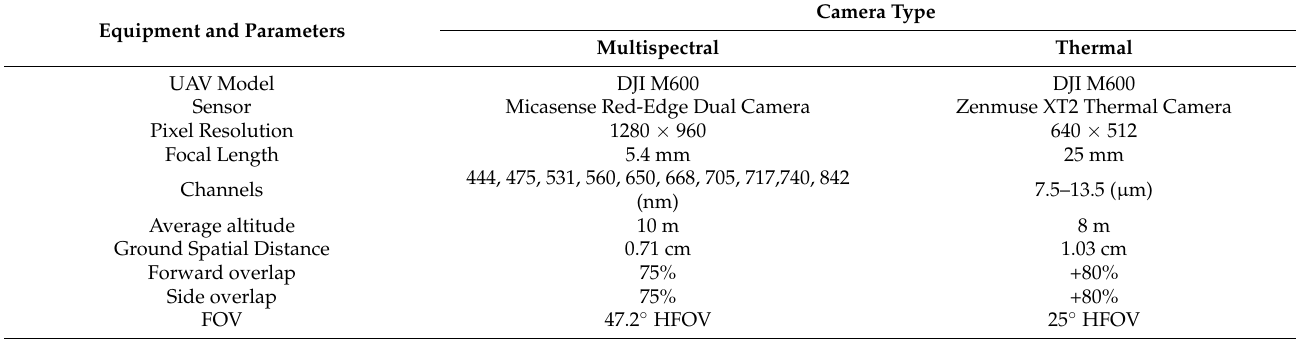
Table 2. Unmanned Aerial Vehicle (UAV) flight operation